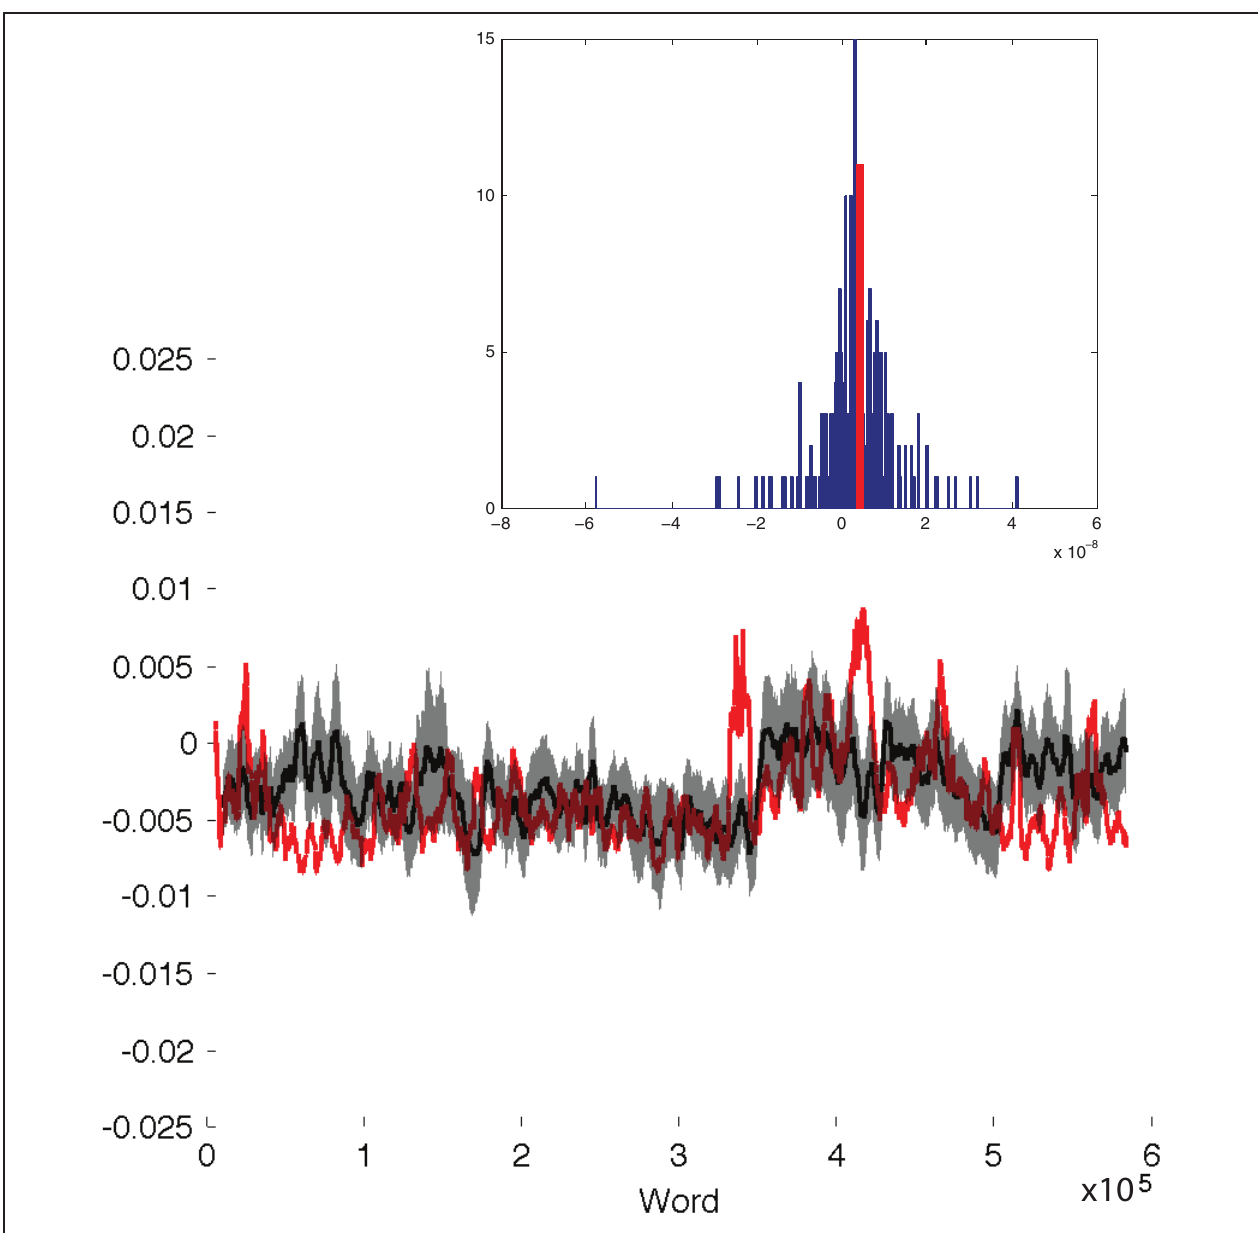
FIGURE A3 | LSA distance to control words in the Old Testament. Black curve shows the mean distance for the control words, with the gray shadow indicating standard deviation. The red curve corresponds to introspection.